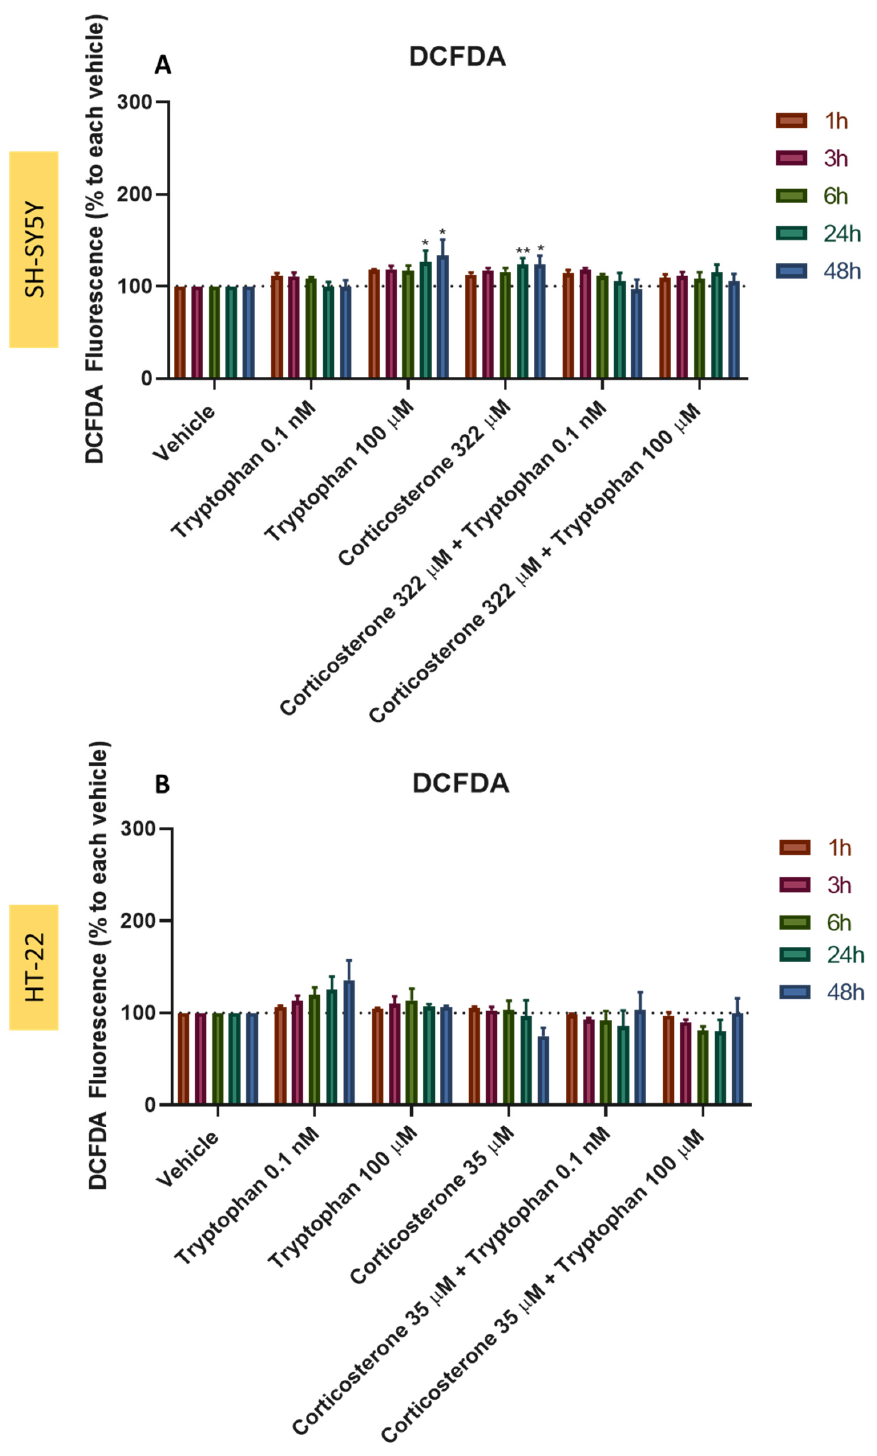
Figure 21. Effect on ROS production of 1 h, 3 h, 6 h, 24 h, and 48 h-incubation of ( A ) 322 µ M of corticosterone, 0.1 nM/100 µ M of L-tryptophan and 322 µ M of corticosterone + 0.1 nM/100 µ M of L-tryptophan (SH-SY5Y cells) and ( B ) 35 µ M of corticosterone, 0.1 nM/100 µ M of L-tryptophan and 35 µ M of corticosterone + 0.1 µ M/100 µ M of L-tryptophan (HT-22 cells), determined by DCFDA assay. The results represent the mean ± SEM of 2–6 independent experiments, expressed as the percentage of each vehicle (100%) for each period. Statistically significant * p < 0.05, and ** p < 0.01 vs. vehicle, for each